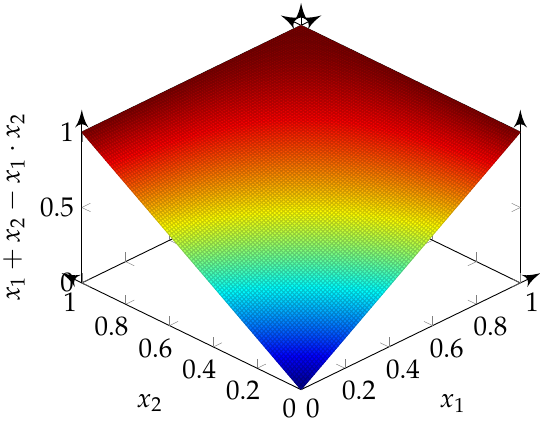
Figure 6. Results of the function x 1 + x 2